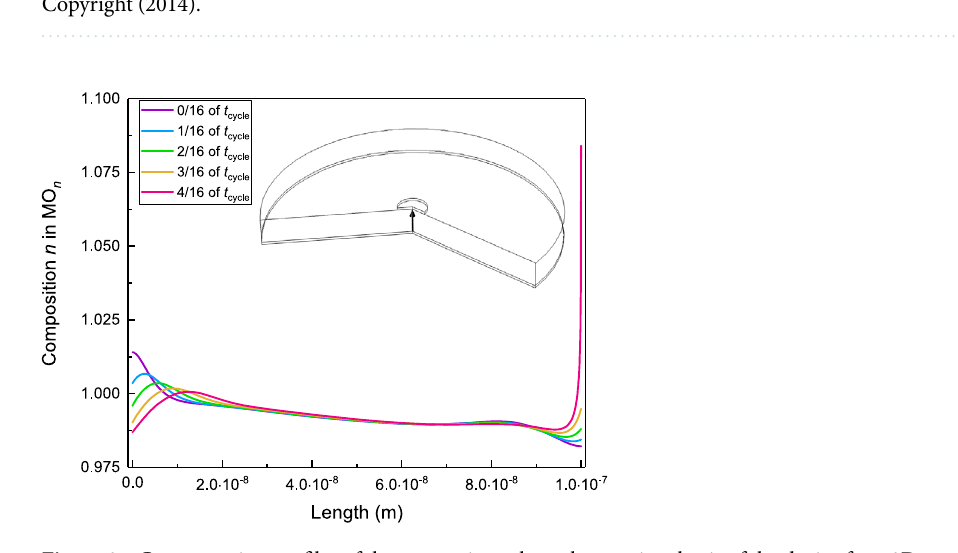
identical to the one–dimensional I – V curves. By increasing the size of the bottom electrode while keeping the size of the top electrode constant, we observed a transition from abnormal to normal bipolar switching. First,